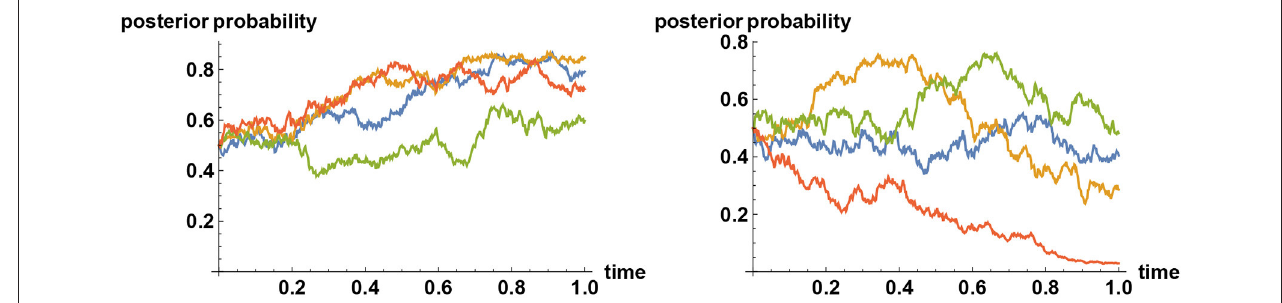
FIGURE 1 | Impact of fake news. The two alternatives are represented by the values X 0 and X 1, but at time zero the uncertainty is at its maximum (the opinion = = is equally split between the two alternatives). Then noisy observation begins, and the prior opinion is updated in time (expressed in years). Plotted here are sample paths for posterior probabilities that X 1. In all simulations the correct choice is (secretly) preselected to be the one corresponding to X 1. Depending on how the = = Brownian noise develops the best inference develops differently, as shown here on the left panel, but by waiting sufficiently long, ultimately enough truth is learned and all decisions on the left panel will converge to the correct one, typically by time t 10. The impact of disinformation, released at a random point in time (at t 0.6 ≈ = here), is shown on the right panel. The disinformation is released at a constant rate in time, intended to mislead the decision maker to select the choice corresponding to X 0. The rate of release is taken to be sufficiently strong that if decision makers are unaware of the disinformation then they will be led to making the incorrect = decision ( X 0), even though the simulator had preselected the correct decision to be that corresponding to X = =